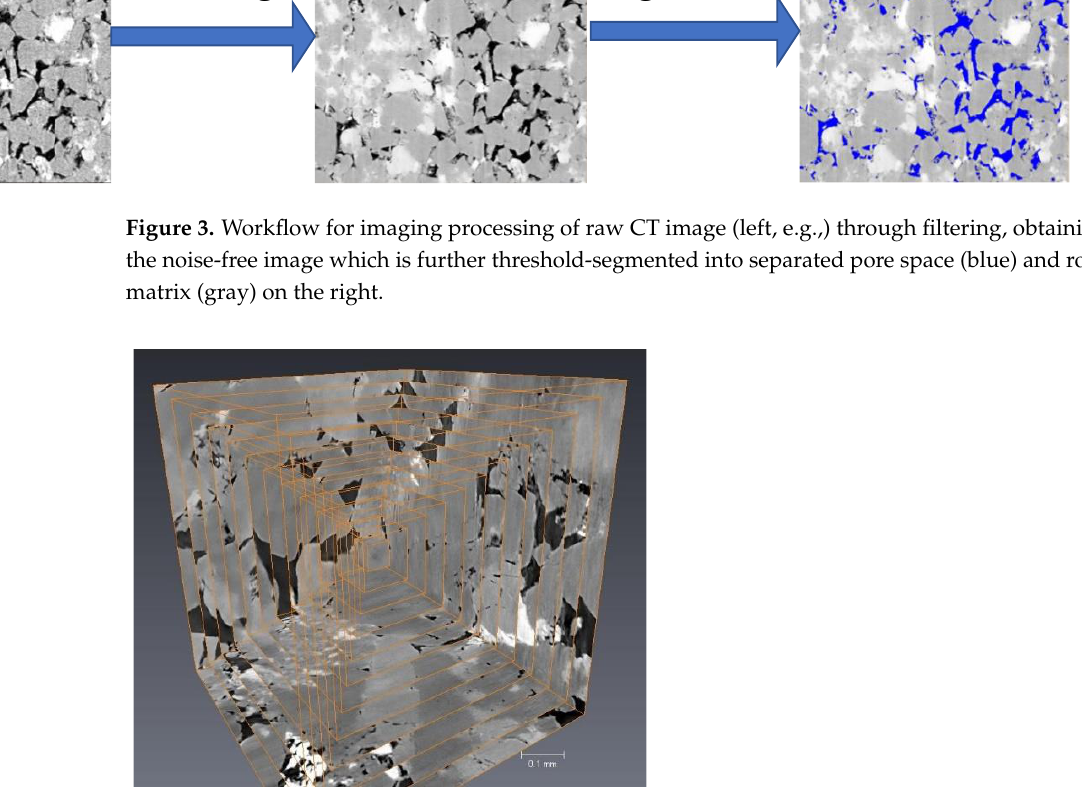
Figure 4. Schematic diagram showing REV central cutting.